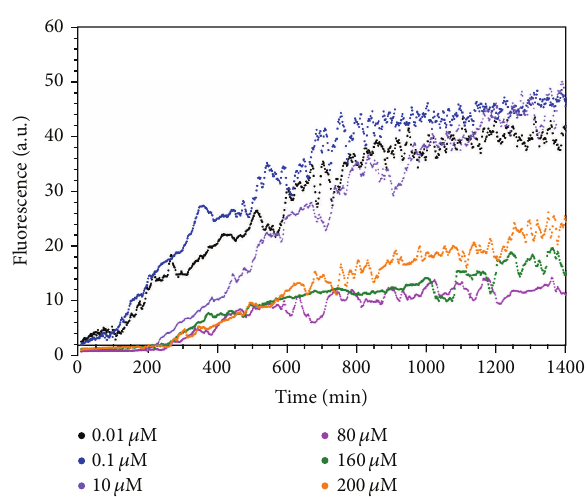
Figure 6: Representative kinetic traces for the fibrillization of WT- amylin at the larger peptide concentration used for the cytotoxicity assays(80 𝜇 Mamylin),andtheindicatedconcentrationsoftheArg-1